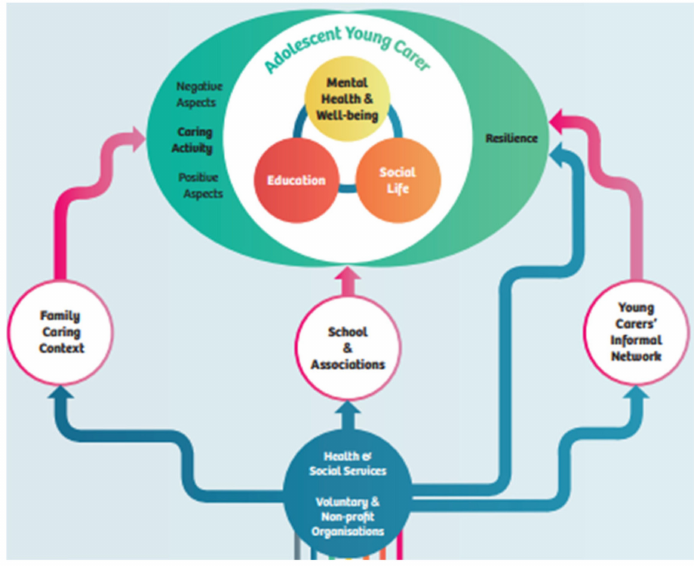
Figure 2. The ME-WE project conceptual